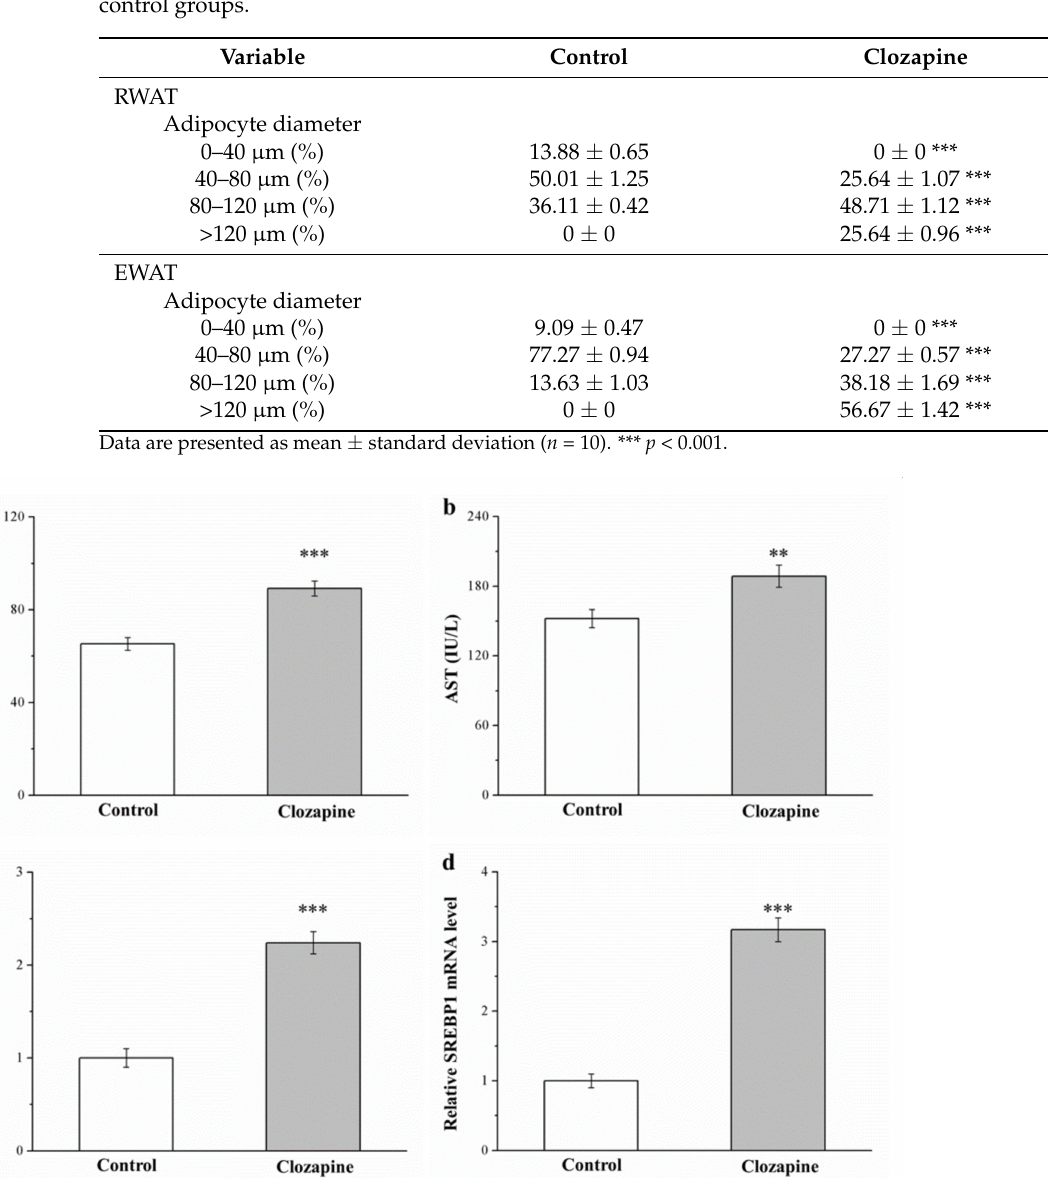
Table 1. Effects of clozapine on fat cell size distribution for clozapine (receiving 2 mg/kg/day) and